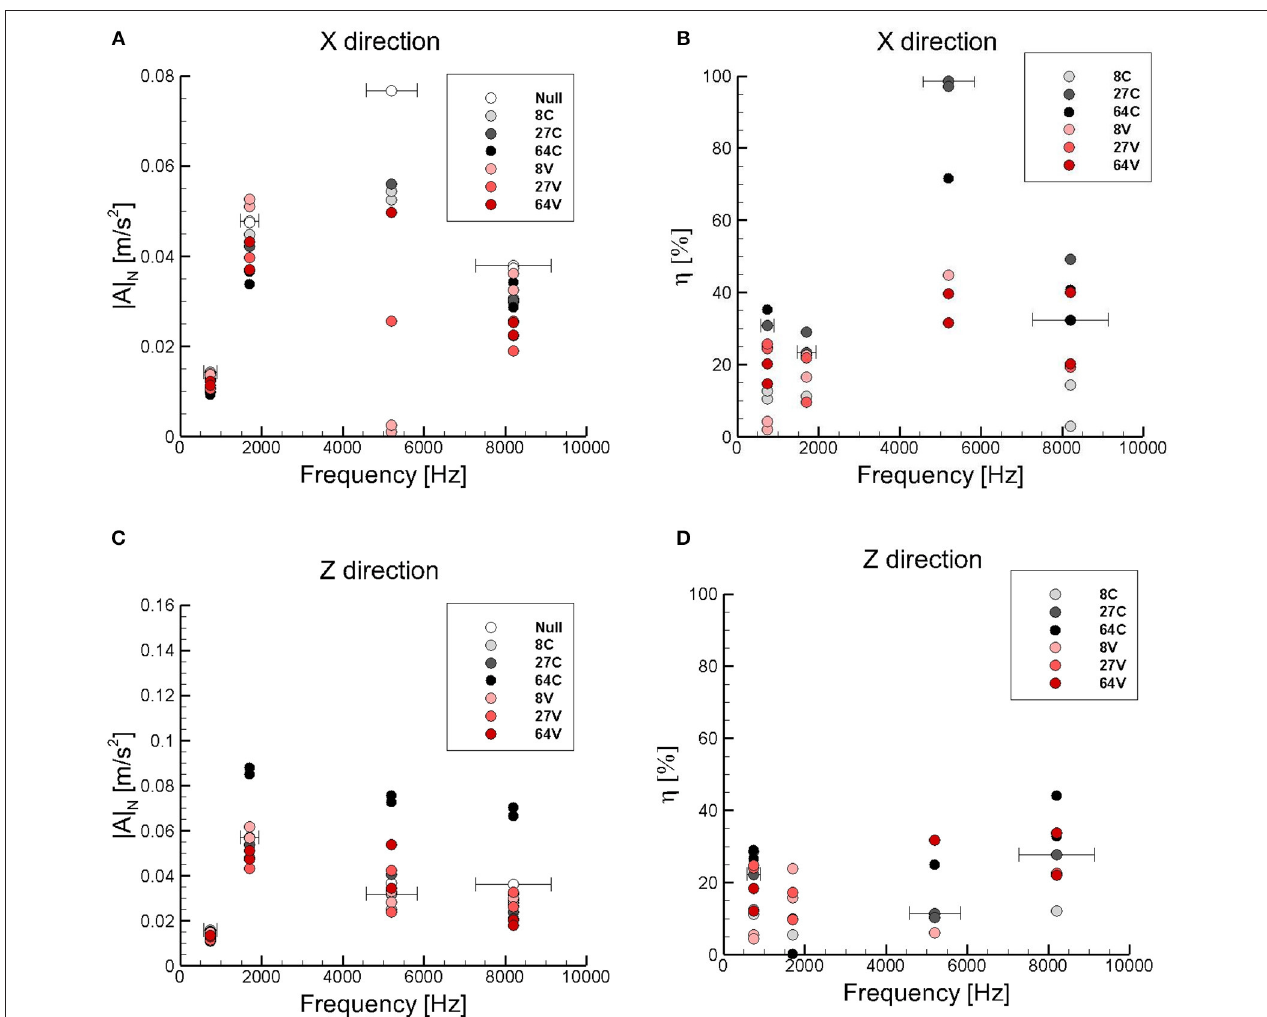
FIGURE 6 | Values of the FFT acceleration amplitude | A | N and efficiency η N averaged in the eigenfrequency bands (visualized by the horizontal bars) for the seven specimens. Signal transmitted in x and z directions. (A) Average FFT acceleration amplitude for signal in x direction. (B) Efficiency for x direction. (C) Average FFT acceleration amplitude for signal in z direction. (D) Efficiency for z